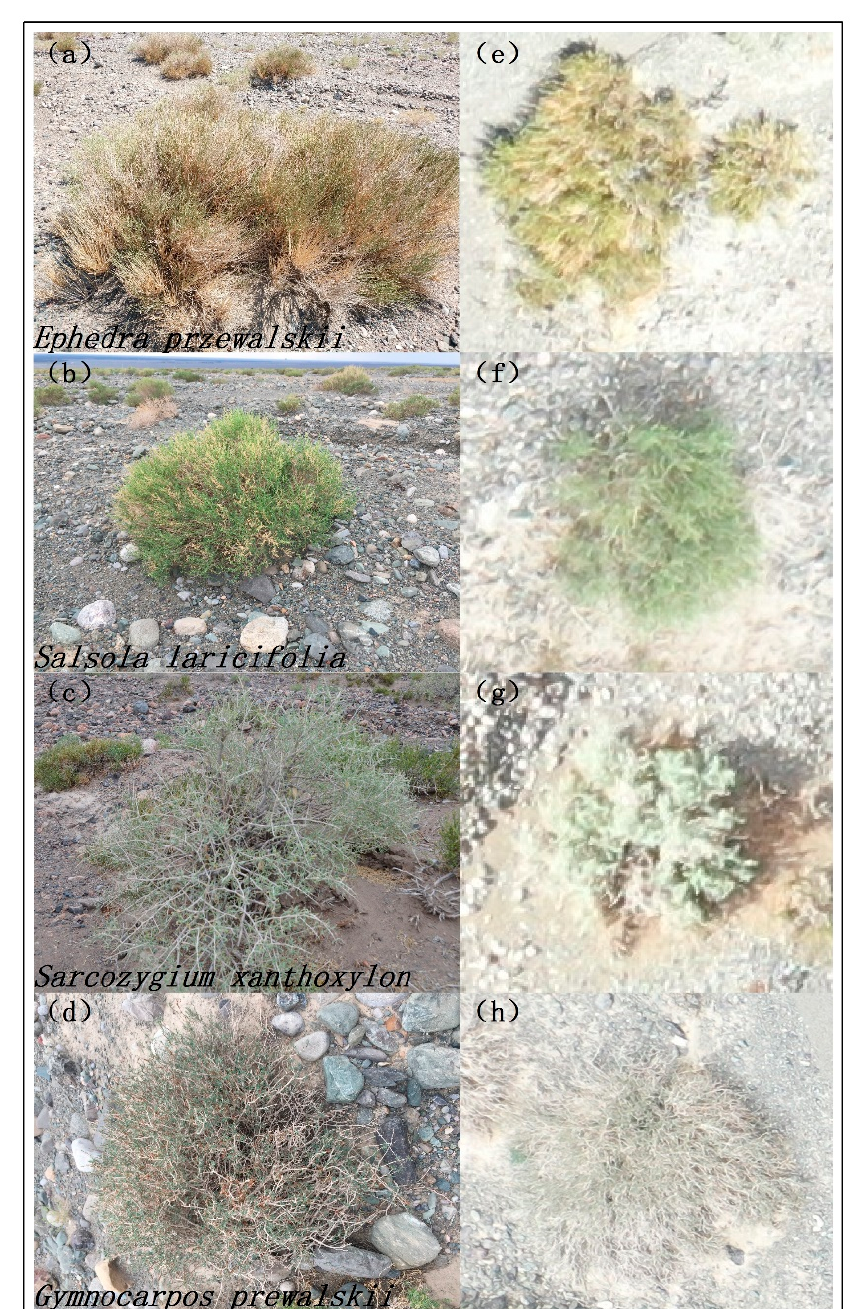
Figure 3. Ground-based photos of different shrub species ( a – d ) and their corresponding unmanned aerial vehicle (UAV) images ( e – h ).